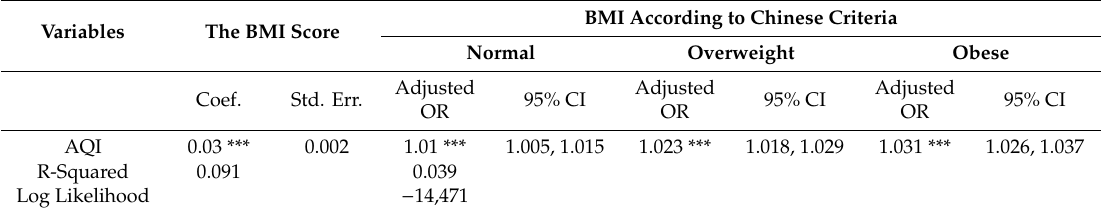
Table 5. E ff ect of Air Quality Index (AQI) on Body Mass Index (BMI): median AQI. Variables